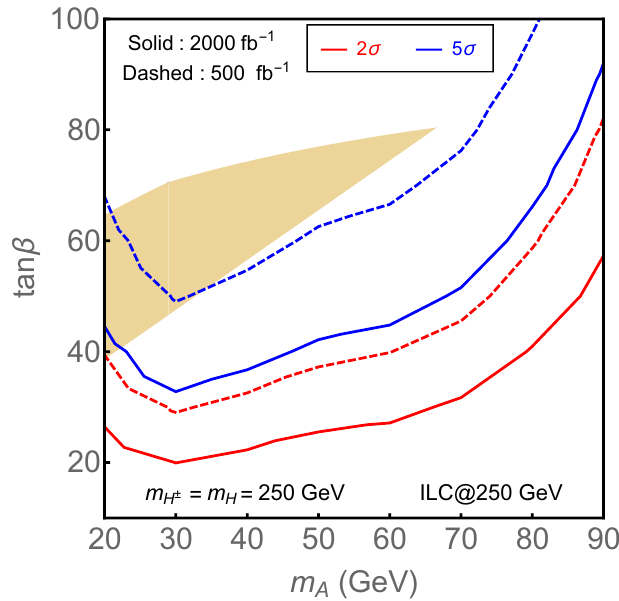
Figure 16. Exclusion and discovery regions in the 2HDM type X model, in the ( m A , tan β ) plane. The color region additionally explains the current g µ lines are excluded. Taken from [58].